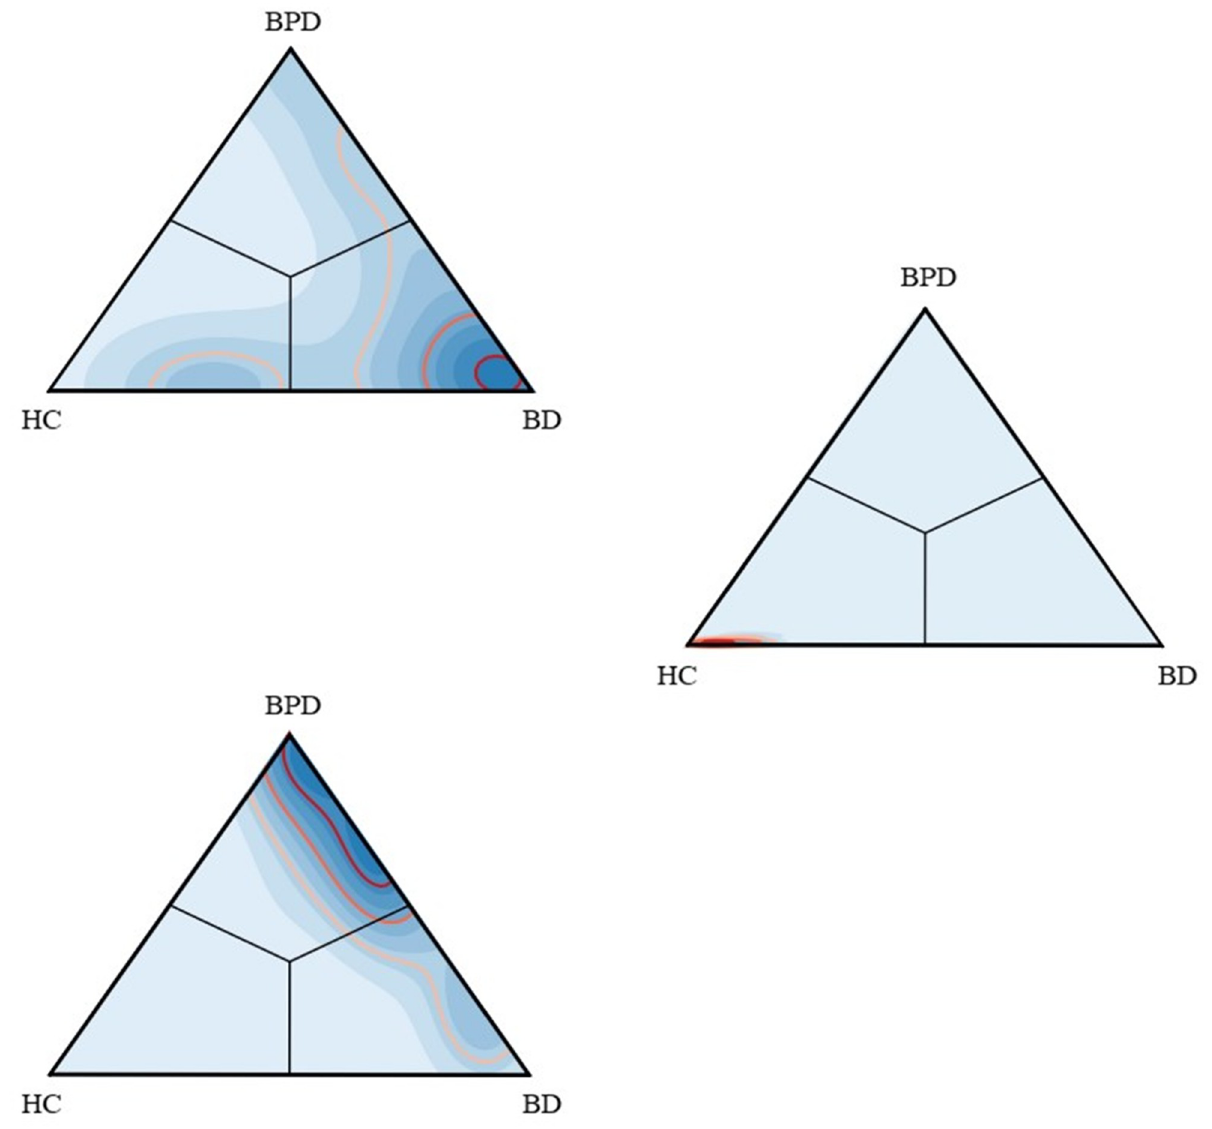
Fig 7. Density plots for the predicted diagnosis from MRLSM: Darker blue areas indicate higher density values, i.e., events that are more likely to happen, and vice versa; red lines indicate the 75% (the lightest red), 50%, 25% (the darkest red) boundaries of density contours, i.e., the events within the area enclosed by the 75% contour line is with probability 75% to happen. Upper: density plot of the predicted diagnosis for BD group. Middle: density plot for the predicted diagnosis for HC group. Lower: density plot for the predicted diagnosis for BPD group.